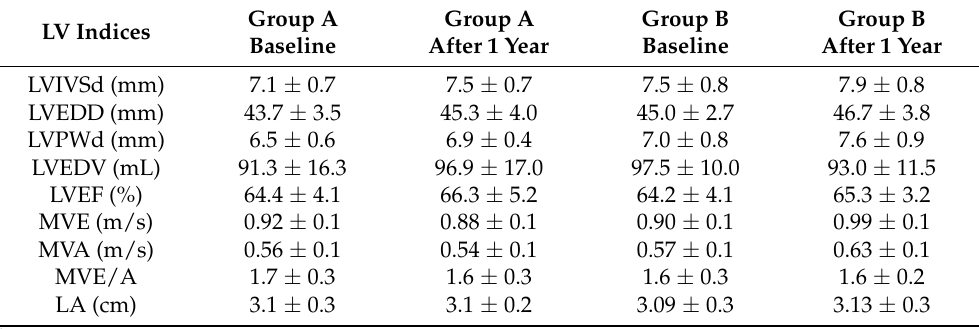
Table 2. Echocardiographic data of LV anatomy and function of both groups at baseline and after one year 1 . Group A LV Indices